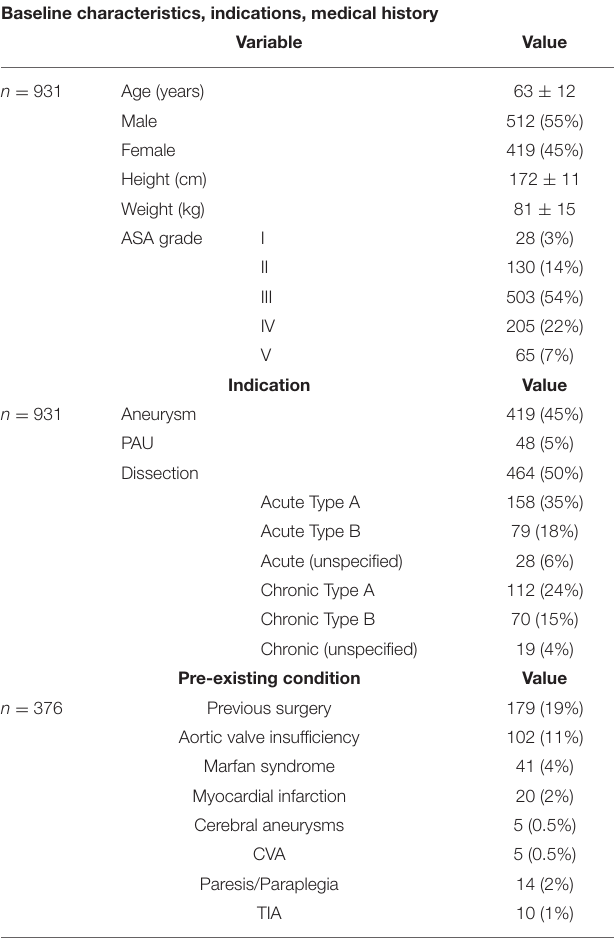
TABLE 1 | Summarised baseline demographic characteristics, indications for use of Thoraflex TM , and relevant past medical history. Baseline characteristics, indications, medical history